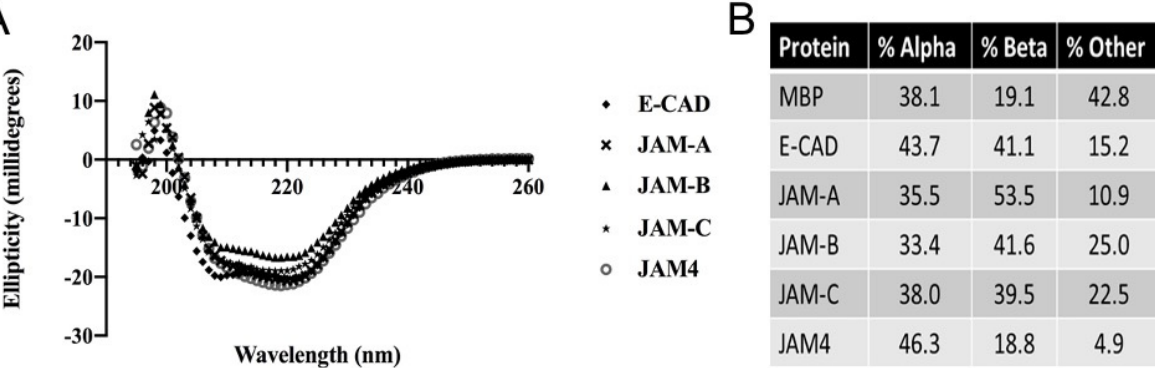
Figure 2. Circular dichroism analysis of JAM proteins and E-CAD. ( A ) Circular dichroism analysis, comparison of all MBP fusion, extracellular domain of E-CAD or JAM proteins. Folding similarities are observed for the behavior of the fusion proteins. ( B ) The analysis of each curve (Materials and Methods) for the target proteins, including non-fused MBP, is presented in a table that describes the distribution of secondary structure. The content of alpha helix, beta sheet or other (coiled) is presented. Our non-fused MBP protein displayed a similar distribution of the secondary structure as previously reported in the literature [35,36].